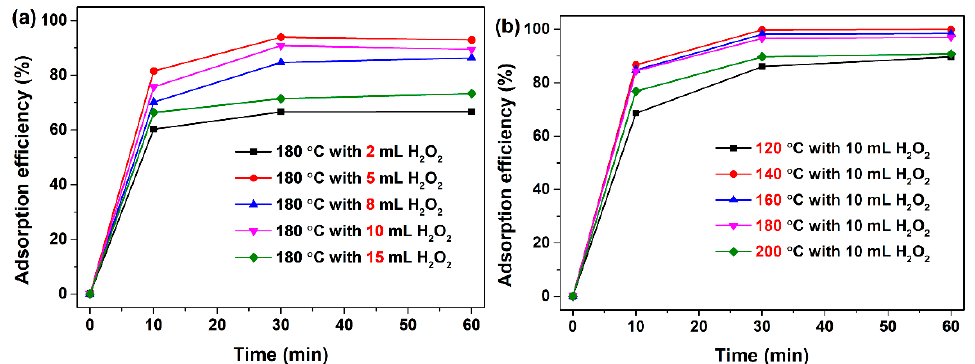
Figure 4. ( a ) Time-dependence of adsorption profiles of AO7 dye without pH pre-adjustment onto mesoporous CeO 2 synthesized hydrothermally at 180 °C for 24 h with a desired amount H 2 O 2 of 2–15 mL and ( b ) synthesized hydrothermally at a set temperature of 120–200 °C for 24 h with 10 mL H 2 O 2 . ([CeO 2 ] = 2.0 g/L; [AO7] = 120 mg/L; V = 100 mL; distilled water; 200 rpm; room temperature).